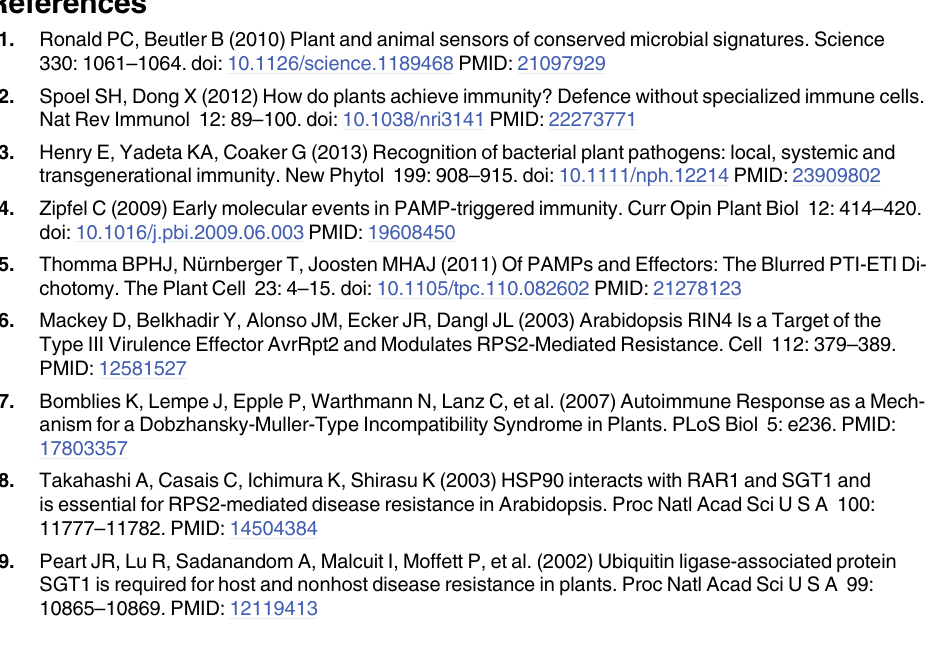
S6 Fig. GAPDH is localized to the nuclear, cytosolic and microsomal fractions. Nuclear, cy- tosolic and microsomal fractions from two-week-old seedlings were isolated using the Minute Plasma Membrane Protein Isolation kit (Invent biotechnologies, Inc). Western blotting using α -GAPDH demonstrates primarily cytosolic localization with some protein found in the mi- crosomal fraction and less in the nuclear fraction. Western blotting with marker proteins was used to verify enrichment of individual fractions. α -F6BP is a cytosolic marker and α -RIN4 is a microsomal marker. A total of 8 μ g of protein was loaded per lane. S7 Fig. Induced autophagy in gapa1-2 and gapc1 is indistinguishable from wild-type Col-0. Two-week-old seedlings were grown on MS media without nitrogen for four days, and then incu- bated with the 50 μ M of the fluorescent dye MDC for 3 h. Autophagy bodies were visualized by confocal microscopy. Two independent images are shown for each genotype. Scale bar = 10 μ m. S1 Table. Primers used in experiments. (5 ’ to 3 ’